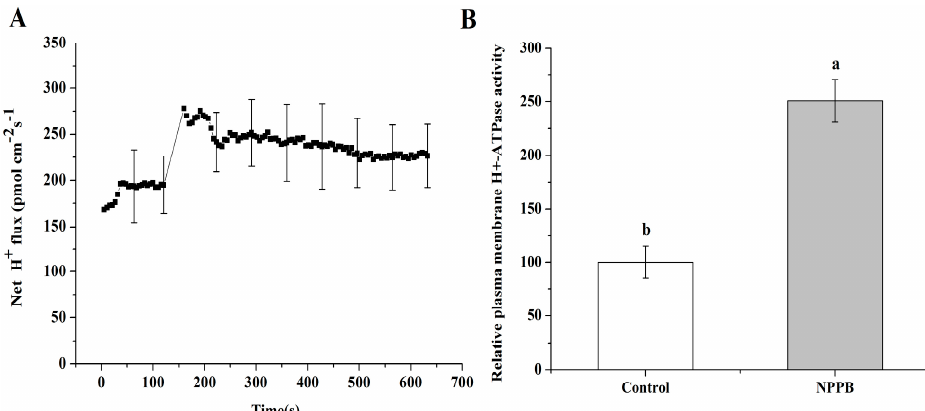
Figure 8. Influence of NPPB on the H + flux and plasma membrane H + -ATPase activity in tea roots. ( A ) The kinetics of net H + flux in tea root mature zone cells treated with NPPB. Data indicate mean ± SD ( n = 6). Error bars indicate differences among the treatments; ( B ) Control and NPPB indicate that tea roots were treated with distilled water and 50 µM NPPB for 12 h, respectively; Data indicate mean ± SD ( n = 4). Error bars indicate differences among the treatments and the letters a, b near the chart bars indicate the level of significance as compared with control at p < 0.05.